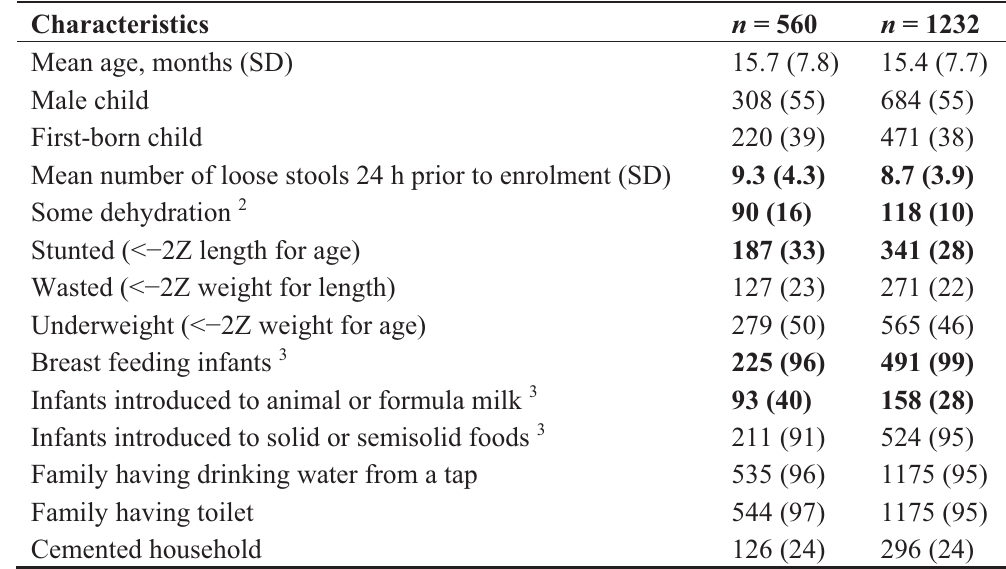
Table 1. Baseline characteristics among children evaluating for anemia and iron deficiency in Bhaktapur, Nepal 1